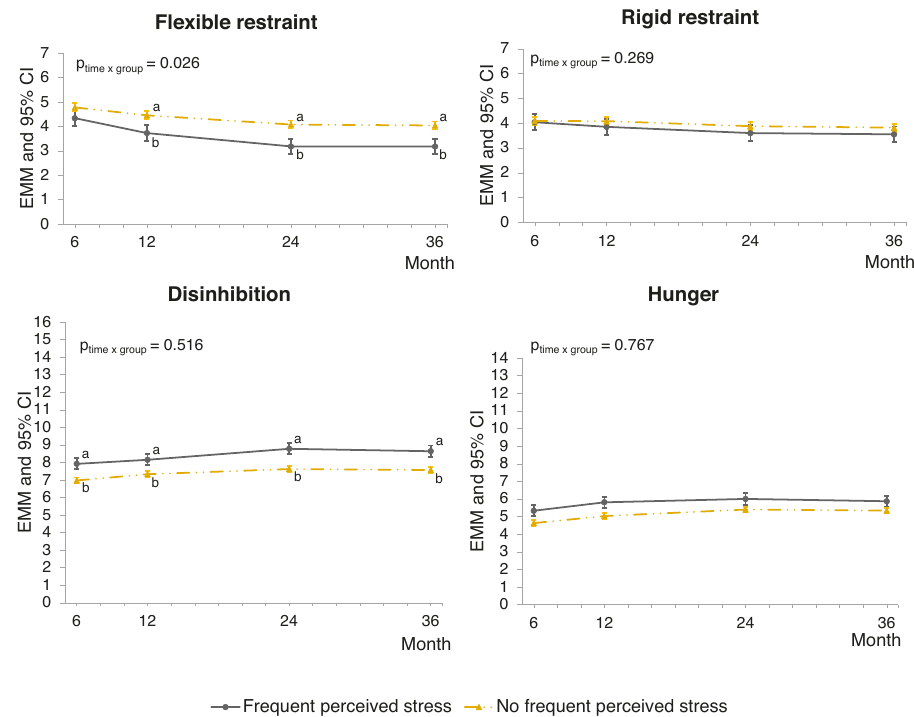
Fig. 1 Estimated marginal means (EMM) and 95% con fi dence intervals (CI) of eating behaviors throughout the behavior maintenance stage of the PREVIEW intervention by stress groups. Individuals with frequent high stress levels ( n = 132) reported high Perceived Stress Scale scores ( ≥ 20) 2 or more time-points during the behavior maintenance stage (6 – 36 months). Determined using linear mixed effects models with maximum likelihood estimation adjusted for age, sex, diet (high vs medium protein), and baseline (month 0) eating behavior and BMI as fi xed effects and participant ID and intervention center as random effects, including group*time interaction term. Pairwise comparisons were conducted at each time point, and signi fi cantly different ( p < 0.05, Bonferroni adjusted) mean values are indicated with different letters.